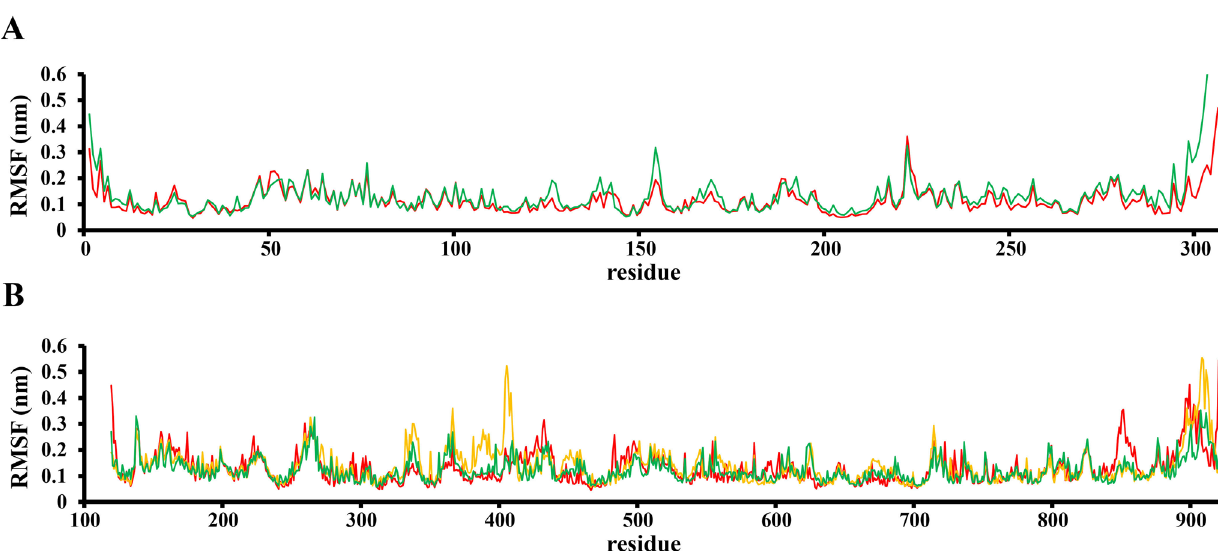
Figure 6. RMSF of the 3CLpro ( A ) and RdRp ( B ) in complex with C 60 fullerene: 3CLpro free protein molecule—green,